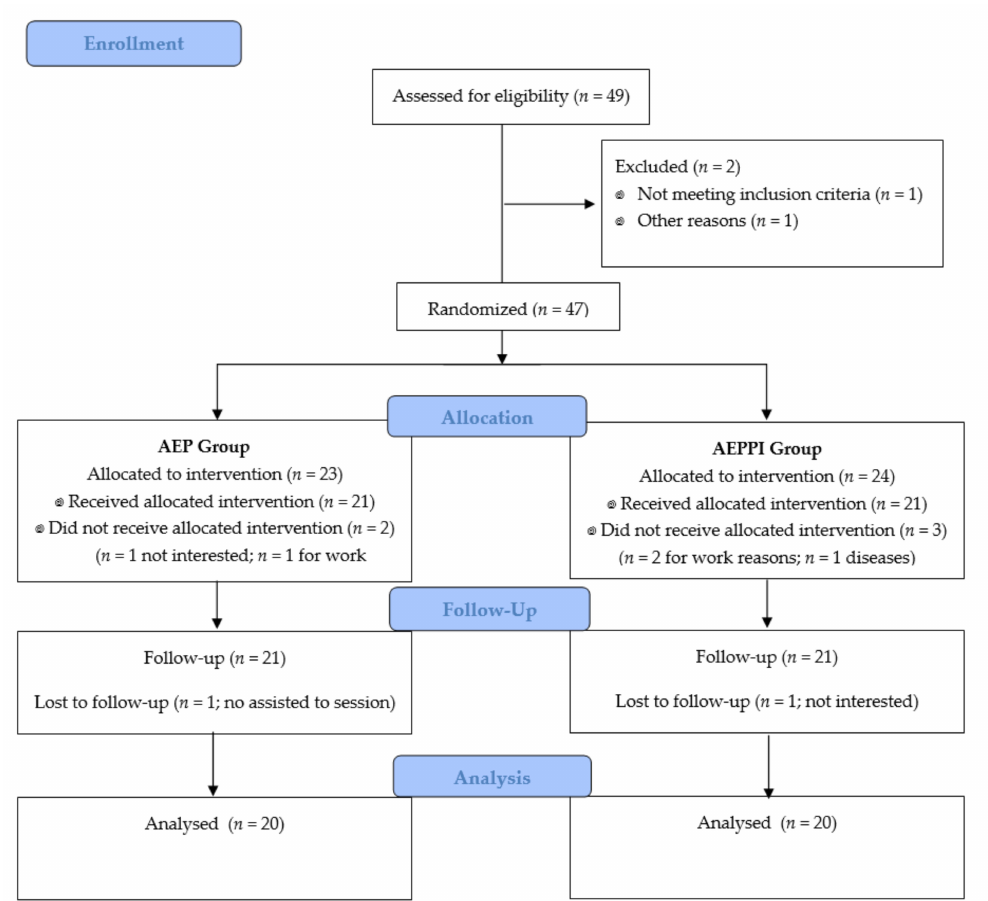
Figure 1. Flow diagram of participants. AEP, Abdominopelvic exercise program; AEPPI, Abdominopelvic exercise program adding postural